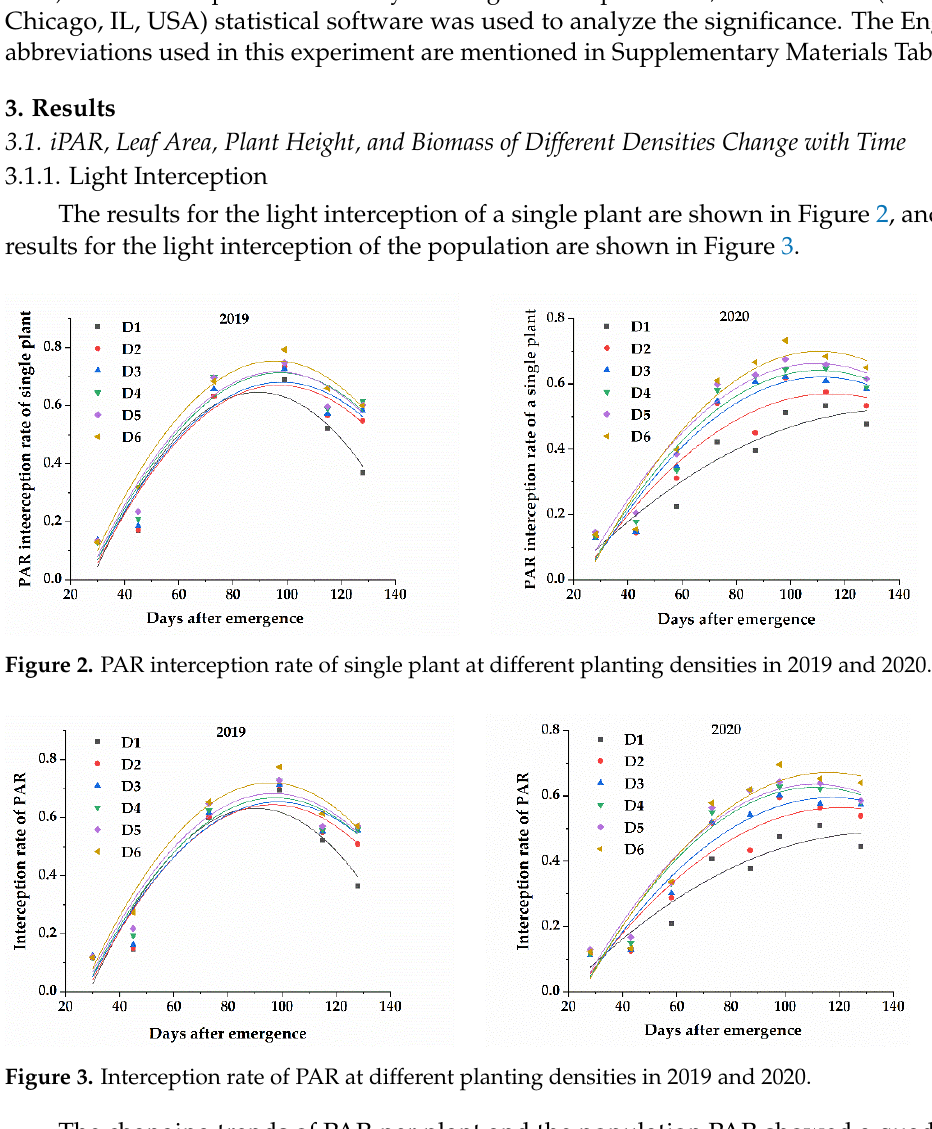
curve with an opening downward. In the early stage of cotton growth, the light intercep-